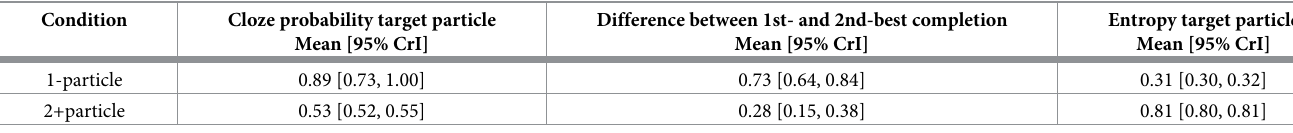
Table 2. Cloze probability summary statistics for Experiment 2.